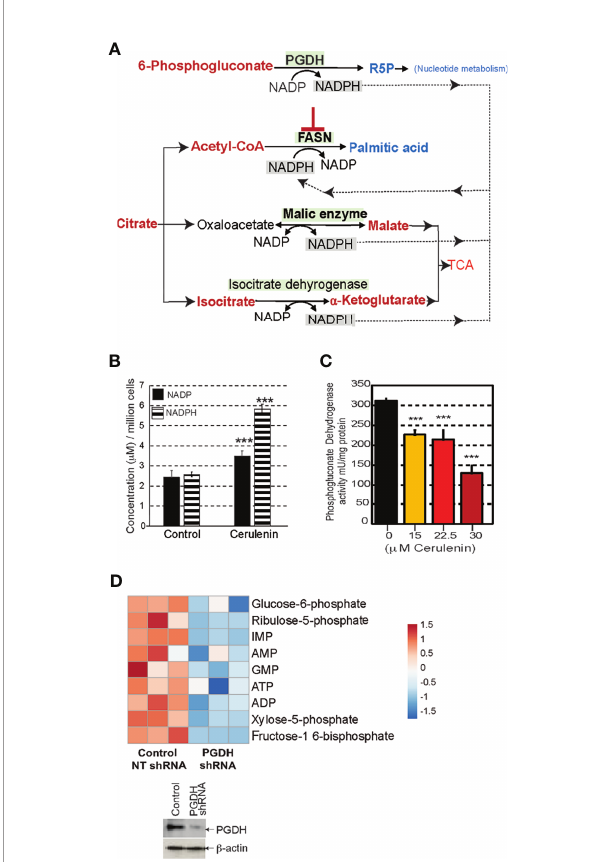
FIGURE 5 | FASN inhibition interrupts phosphogluconate dehydrogenase (PGDH) activity. (A) Schematic representation of the metabolic impacts of FASN inhibition on potential enzymatic sources of NADPH for FASN activity; elevated metabolites are shown in red, and decreased metabolites are shown in blue. (B) Bar graph representing changes in concentrations of NADP or NADPH comparing untreated control and cerulenin treatment (on x-axis), and concentration represented as m M/million cells (on y-axis) in SUDHL10 cells. Data represented are based on averages from experimental triplicates, comparing cerulenin-treated cells with untreated control, with *** denoting P < 0.001. (C) Bar graph representing PGDH enzymatic activity in SUDHL10 cells treated with cerulenin, with the concentration shown on x-axis, and enzyme activity normalized by mU/mg of total protein (on y-axis). All experiments were performed in triplicates. The error bars in all bar graphs represent the standard deviations of mean, and the signi fi cant difference between control and treatment is indicated by an asterisk (*** p < 0.005), statistically determined by Student ’ s t -test. (D) Heat map representing the metabolic impacts of shRNA-mediated PGDH knockdown compared with non-targeted control in SUDHL4 cells, shown as log 2 -transformed, row- centered data from experimental triplicates. Western blot representing the extent of PGDH knockdown observed with shRNA-mediated RNA silencing in SUDHL4